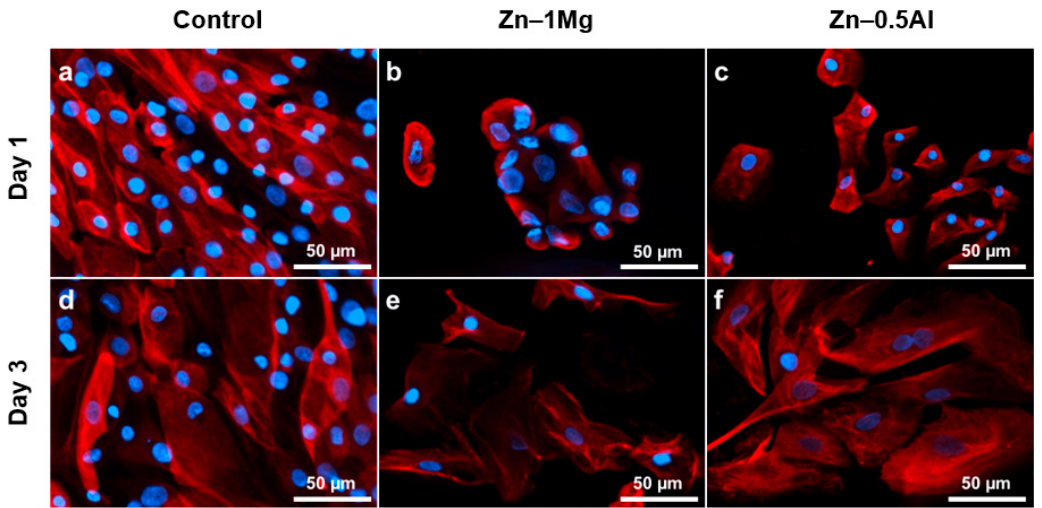
Figure 3. Images of cytoskeletal observation at days 1 and 3 in controls, Zn–1Mg, and Zn–0.5Al groups. Note: anti-cytokeratin 8 / 18 (red) staining was used to examine the changes of keratin, and Hoechst (blue) was used to stain nucleus of the normal human urothelial cells (NHUCs).